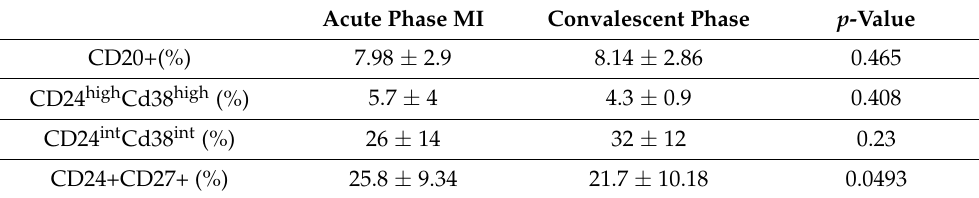
Table 3. Comparison between levels of B-reg subgroups in patients after MI in acute and convalescent phase ( n = 9). Acute Phase